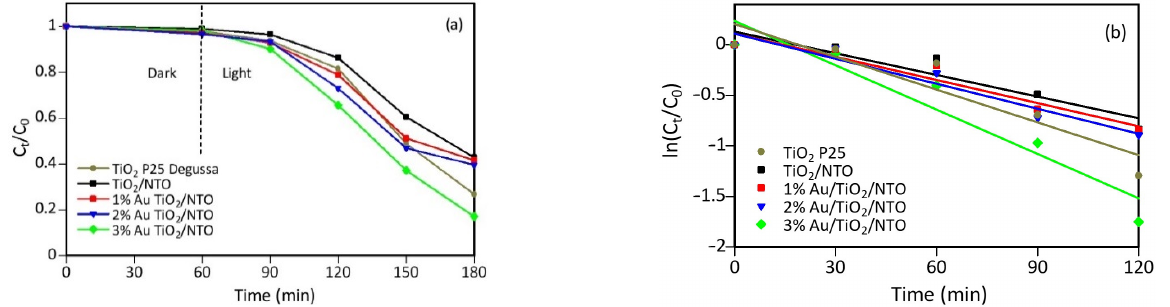
Figure 8. ( a ) Decreased phenol concentration from Au/TiO 2 /NTO composite and TiO 2 P25 standard, and ( b ) first-order Langmuir–Hinshelwood kinetics study on phenol degradation photocatalyst, with the initial concentration of 20 mg/L and 25 mg catalyst. Table 5. Percentage of adsorption and degradation for phenol photodegradation and parameters of kinetic